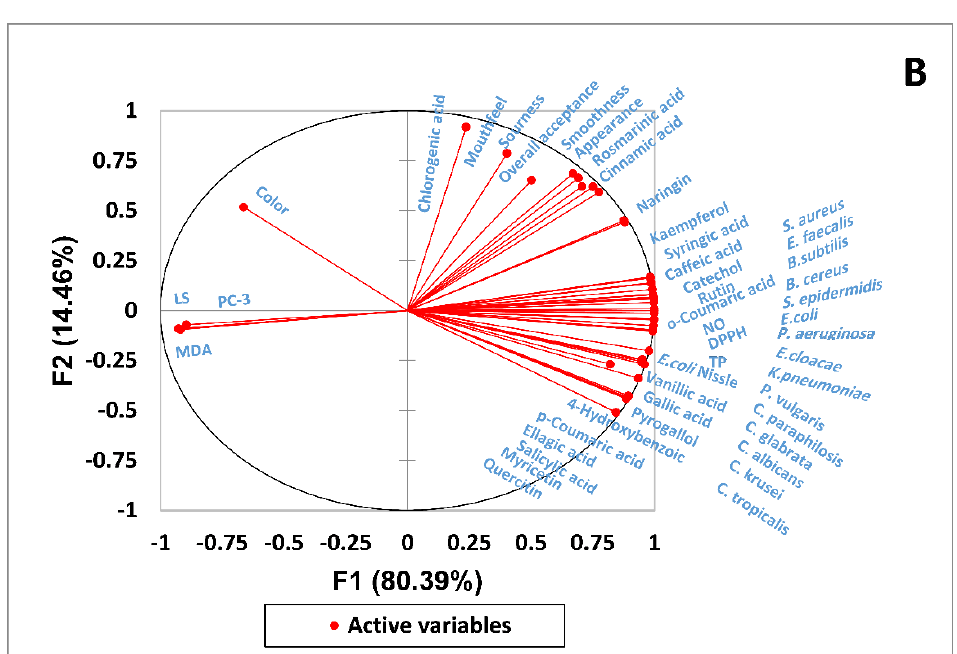
Figure 7. ( A ) Principal component analysis (PCA) biplot of YCG parameters. ( B ) The analysis of correlation variables.